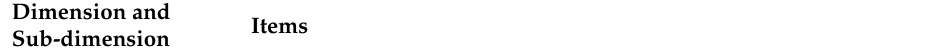
Table A2. Effort, reward, and overcommitment items (translated from German to English). Dimension and Items Sub-dimension Effort